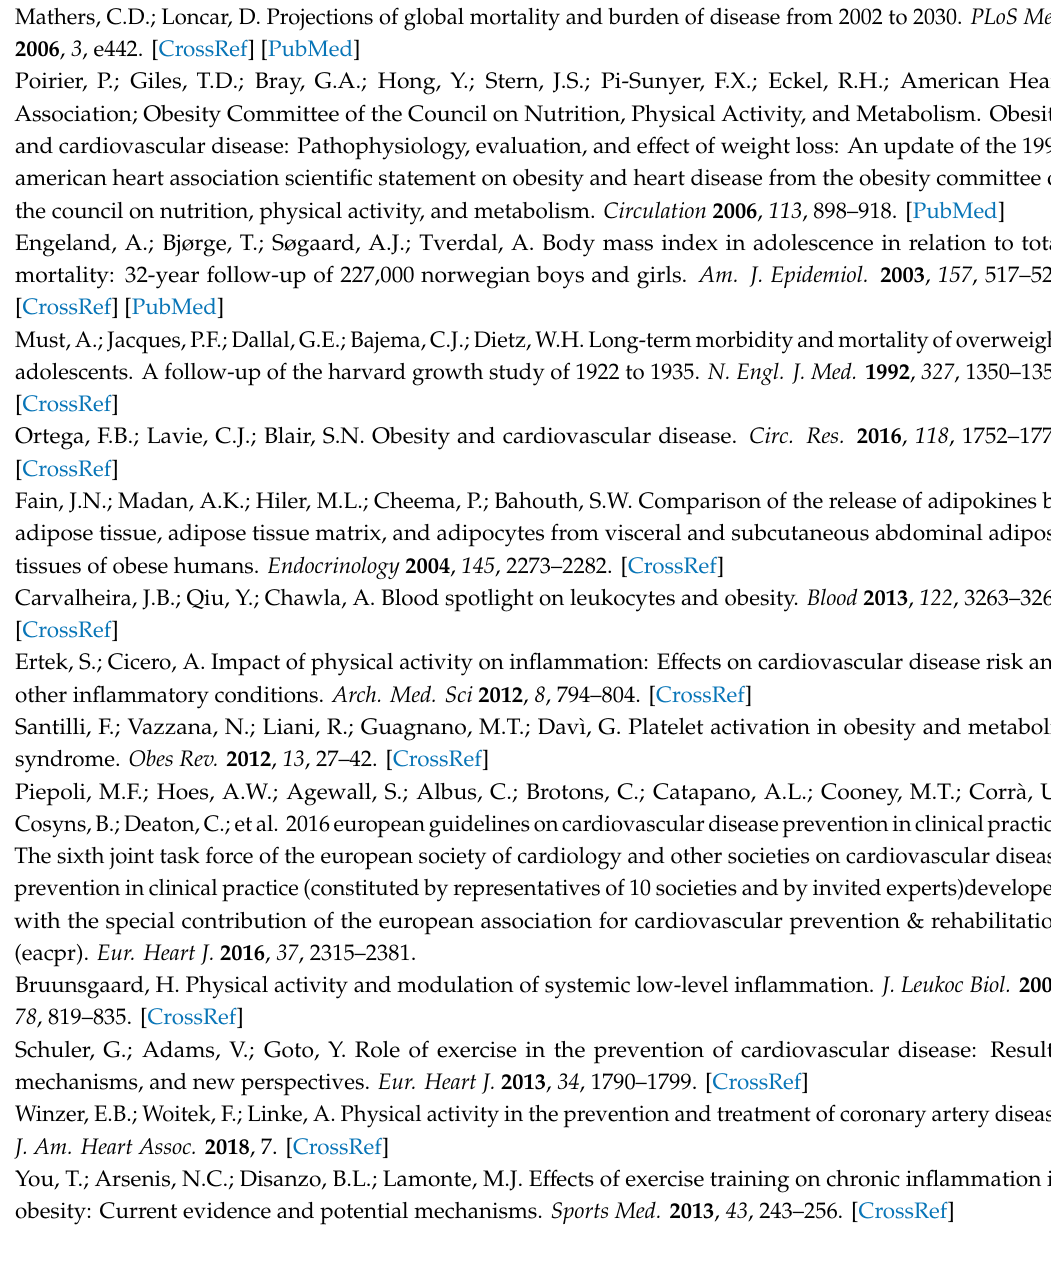
Table S1: Primers sequences of the analyzed genes. Table S2: F and P values referred to each graph analyzed by Two-way ANOVA or Three-way